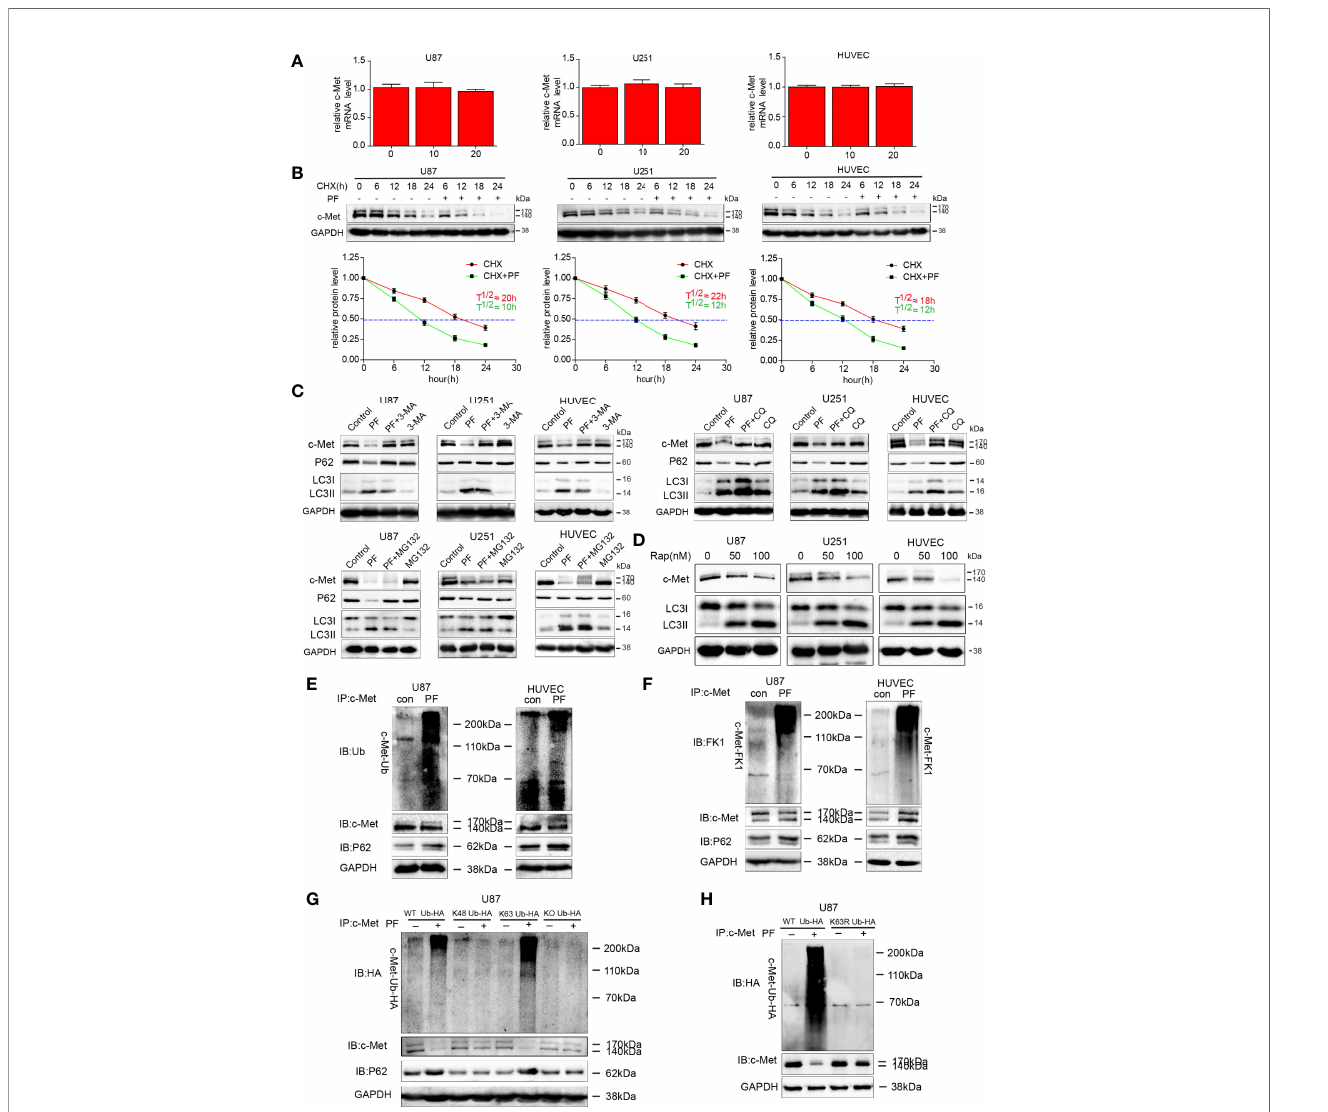
FIGURE 5 | Paeoni fl orin promoted K63-linked c-Met polyubiquitination-dependent autophagic degradation in glioblastoma cells and HUVECs. (A) c-Met mRNA expression was detected by qRT-PCR in cells treated with different concentrations of paeoni fl orin and was normalized to GAPDH expression. Expression was expressed as a fold change relative to 0 m M paeoni fl orin-treated U87, U251 cells and HUVECs. (B) U87, U251 cells and HUVECs were incubated with 5 mM 3-MA, 20 m M CQ or 5 m M MG132 for 6 hours before being treated with 20 m M paeoni fl orin or PBS for 18 hours. c-Met protein expression was estimated by western blotting. (C) U87, U251 cells and HUVECs were treated with 50 nM or 100 nM rapamycin for 24 hours. c-Met and LC3 protein expression was assessed by western blotting. (D) Time course of c-Met degradation. Top panel, CHX (100 m g/mL) was added to U87, U251 cells and HUVECs treated with or without 20 m M paeoni fl orin for 24 hours, after which western blot analysis was performed. Bottom panel, quanti fi ed c-Met band intensities, which are representative of three separate analyses by ImageJ (National Institute of Mental Health, Bethesda, MD, USA). The relative intensities of each band from the cell samples were quanti fi ed by densitometry as a function of time, with the dotted line ( — ) indicating the half-life (T½) of c-Met protein in U87 and U251 cells and HUVECs. U87 cells and HUVECs were treated with paeoni fl orin (10 m M in U87 cells and 20 m M in HUVECs) for 24 hours. The lysates were subjected to immunoprecipitation, which was performed with antibodies against c-Met, and immunoblot analysis, which was performed with antibodies against (E) ubiquitin (P4D1) that recognized monoubiquitin and polyubiquitin and (F) antibodies against FK1 that recognized polyubiquitin and p62. U87 cells transfected (G) with HA – Ub (WT), HA-UbK48, HA-UbK63 or HA-UbKO or (H) with HA – Ub (WT), HA-UbK63R for 12 hours followed by incubating with 20 m M paeoni fl orin for 24 hours. The lysates were subjected to immunoprecipitation with antibodies against c-Met and immunoblot